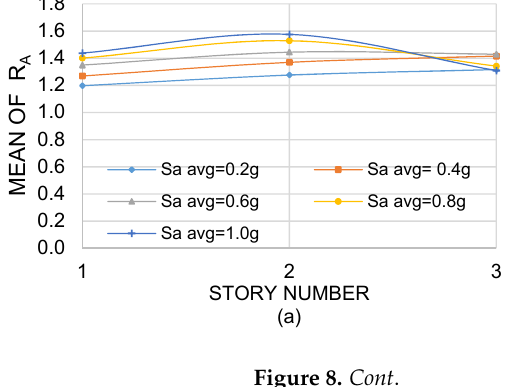
Figure 8. Mean values of R A , NS : ( a , c , e ), exterior columns of Models 1-2-3, respectively; ( b , d , f ), inte- rior columns of Models 1-2-3, respectively. There are many considerable differences in the responses for interior columns with respect to those of exterior columns. The axial loads on interior columns of the 3-story model, the individual, and average underestimations are up to 44% and 30%, respectively. The corresponding values for the interior columns of the 9- and 20-story models are about 18% and 8%. One of the reasons for this is that, for a given floor, the interaction between beams and exterior columns is expected to be very different from that of the interiors, since the former are connected to columns only at one end, while the latter are connected at both ends. The mean values of R B for the NS direction, for all columns and models, are shown in Figure 9. It is observed that for exterior columns (Figure 9a,c,e) the flexural moments may be considerably underestimated when M L is used. The amounts of underestimation increase as Sa avg and the story number increase; in contrast, they tend to decrease as the model becomes taller. The maximum values are about 0.65, 0.68 and 0.80, indicating av- erage underestimations of 35%, 32% and 20%, for Model 1, 2 and 3, respectively. Consid- ering individual seismic records, the corresponding maximum levels of underestimation are about 66%, 58% and 42%. As for axial loads, the underestimation of flexural moments